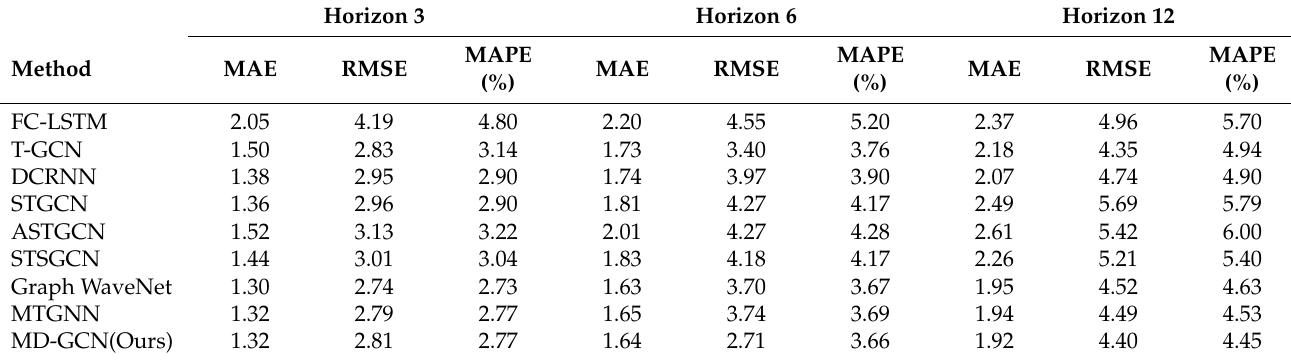
Table 4. The comparative results on PEMS-BAY.